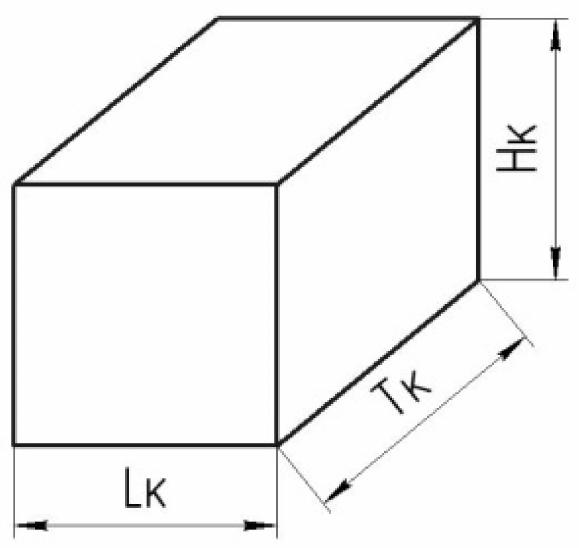
Figure 8. Soil sample diagram.